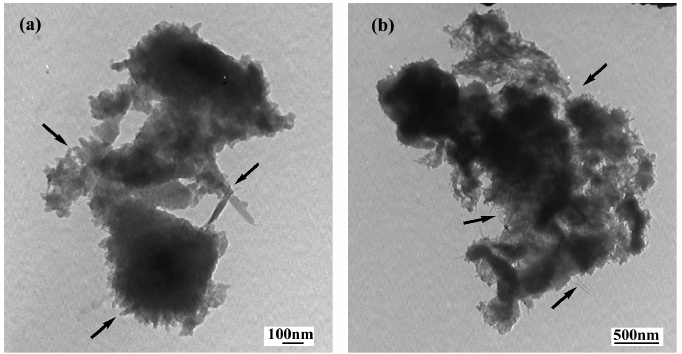
Figure 6. TEM images of the PANI/SWNTs composites with 8 wt% SWNTs from different scopes and magnifications: ( a ) 60,000×; ( b )